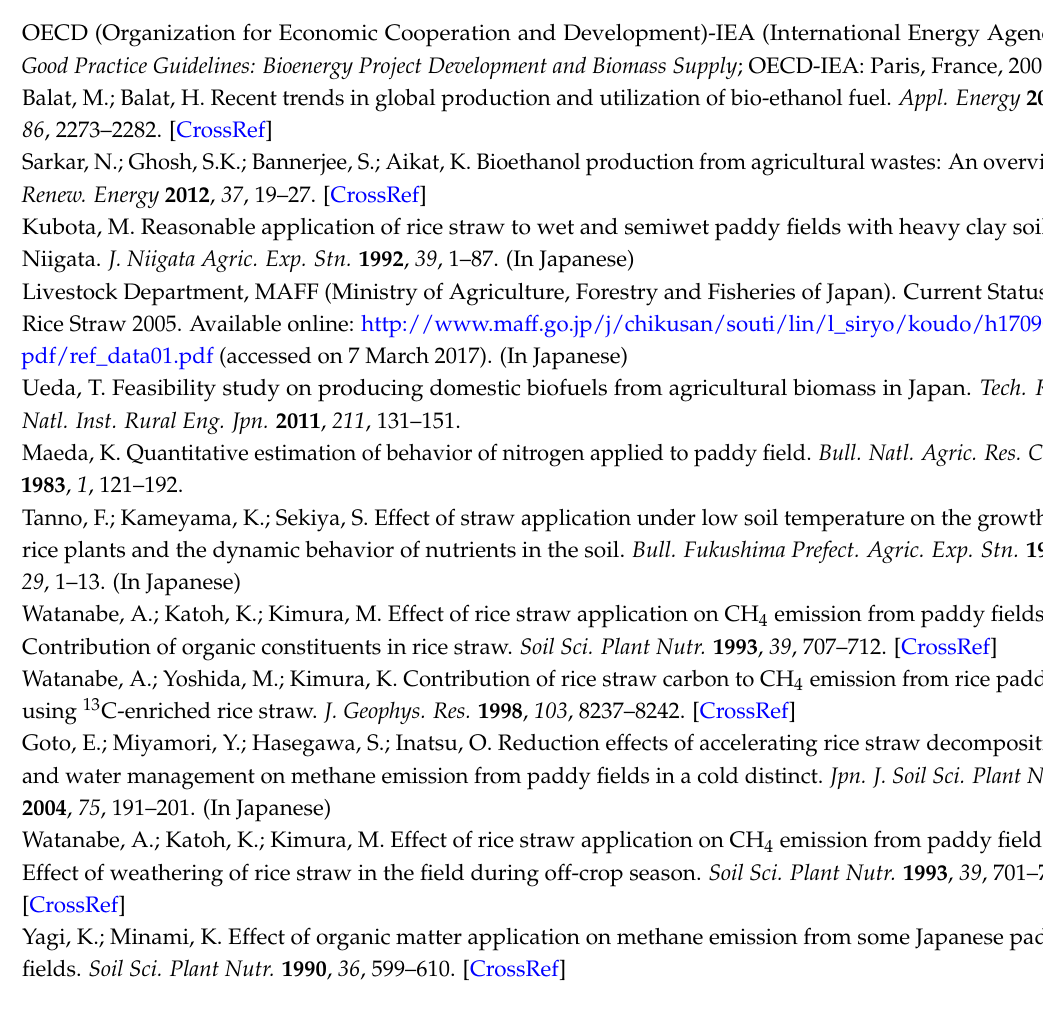
Figure S1: Ethanol production residue used to this study (left) and the experimental plot after scattering the residue (right), Figure S2: Nitrogen (N) mineralization rate of the bio-ethanol production residue used in this study. Mineralized N was evaluated as ammonium–N released by an incubation mixed with soil (150 mg N 100g − 1 dry soil) under flooded condition. N mineralization rate was calculated by dividing the amount of mineralized N by the amount of applied N. The measured value was fitted with the following equation based on kinetics analysis. N = N 0 (1-exp[ kt ]) + I ; where N , N mineralization rate (%); N 0 , rate of potentially mineralizable N (%); k